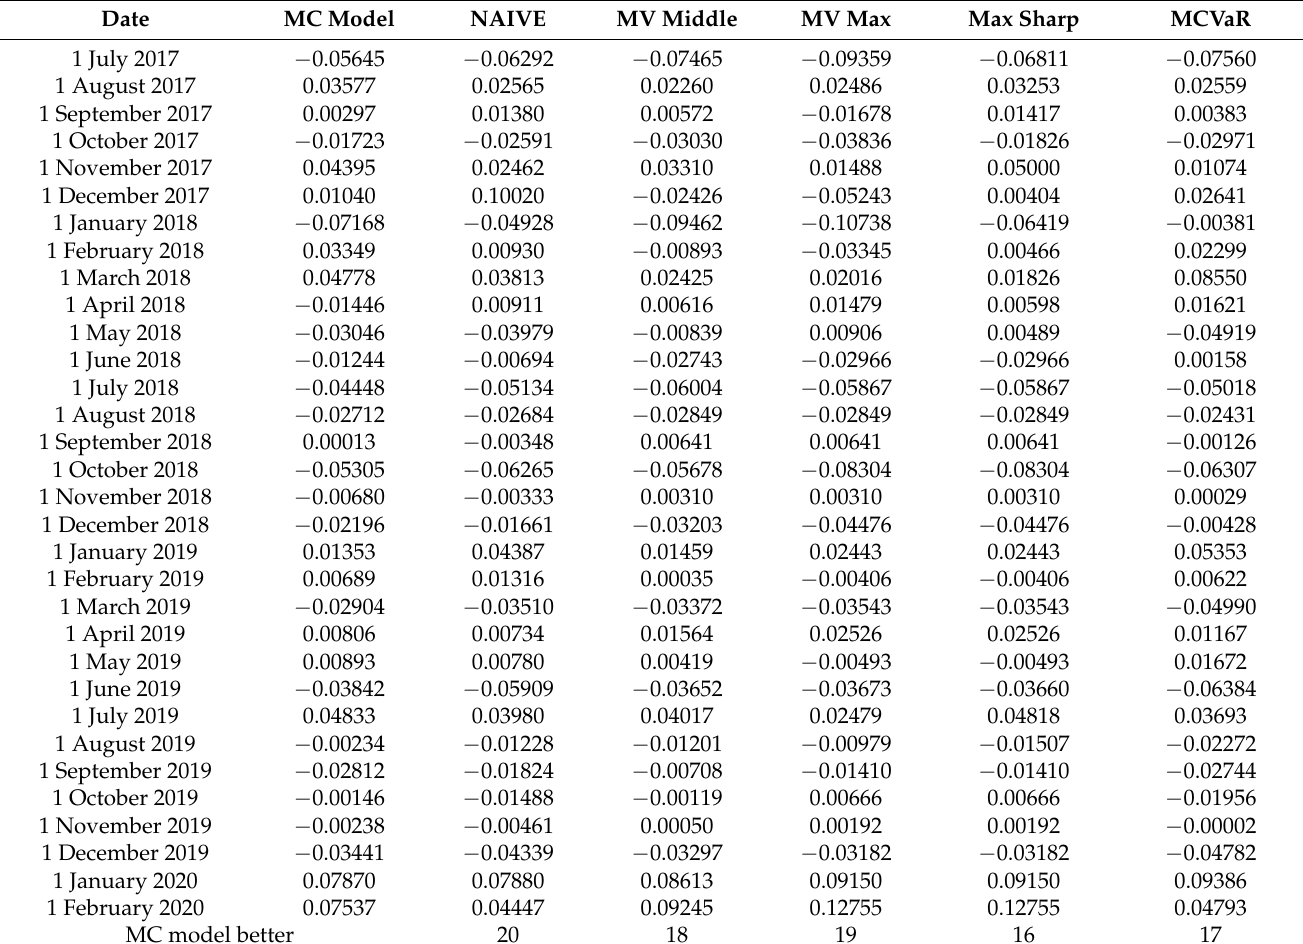
Table A4. Returns of the portfolios in the next trading